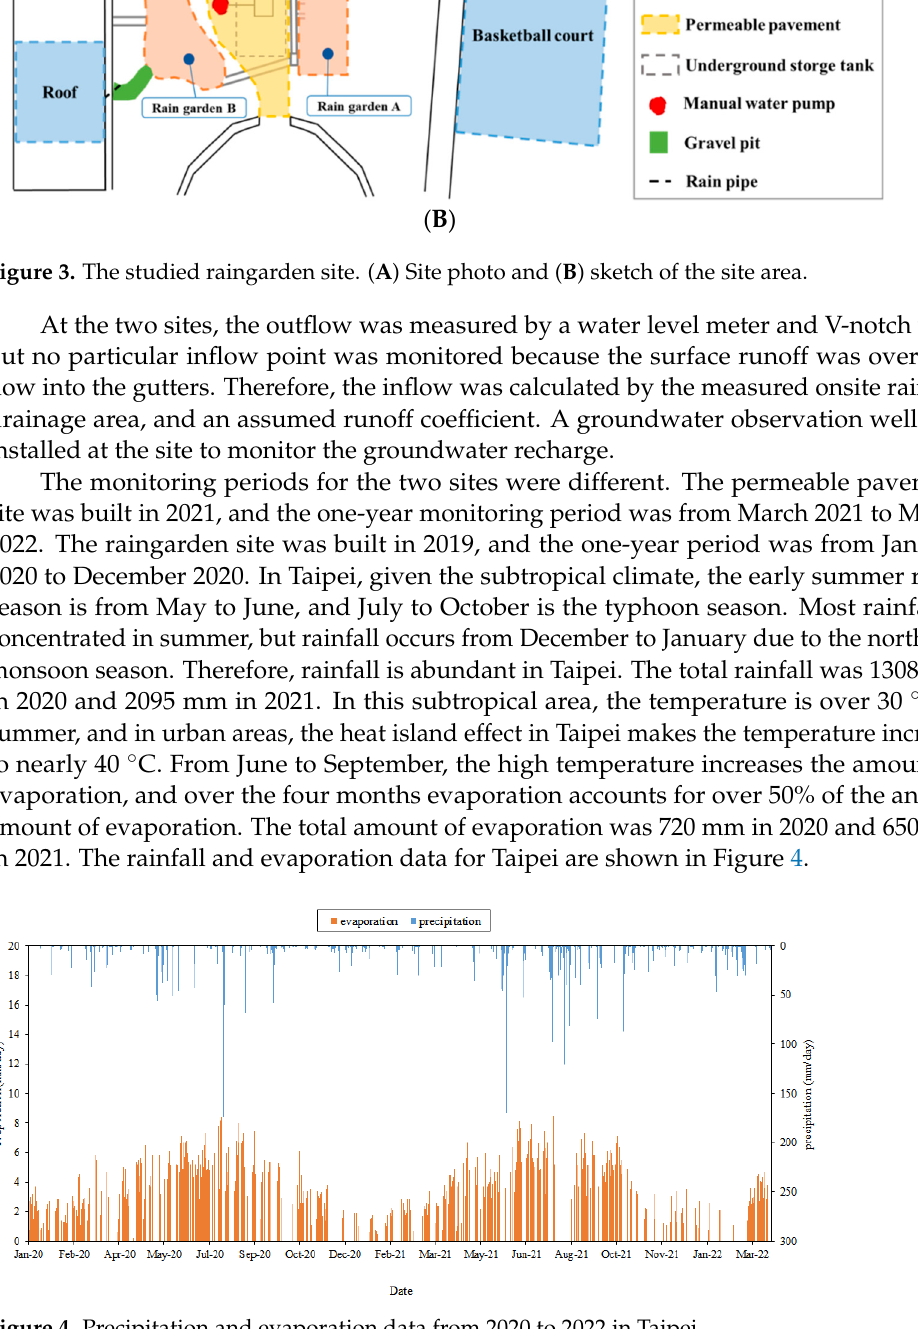
Figure 4. Precipitation and evaporation data from 2020 to 2022 in Taipei.